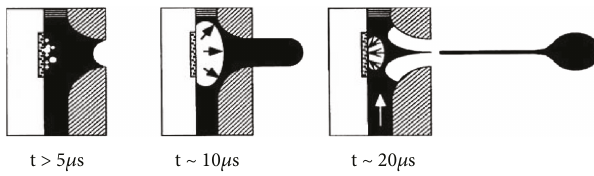
Figure 1: Drop formation by a thermal inkjet printer